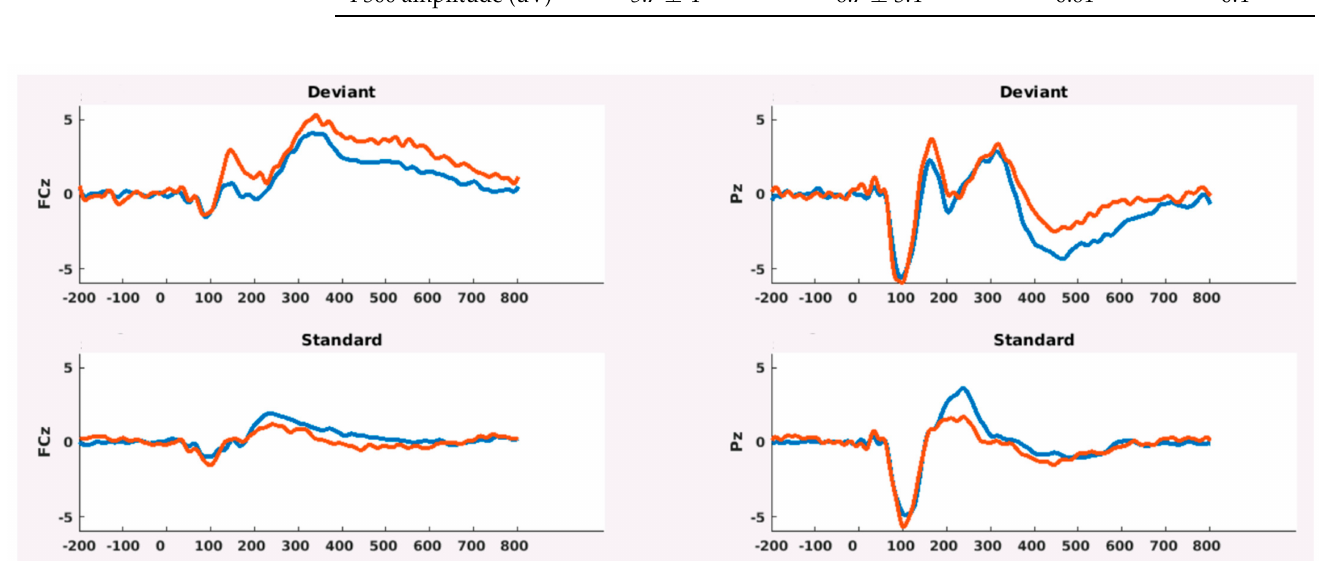
Figure 1. Grand Average of P300 in 19 HCs (blue trace) and 16 pwMs (red trace). Values are represented in uV. No relevant differences in topographical distribution emerged between pwMS and HCs (Figures 1 and 2).